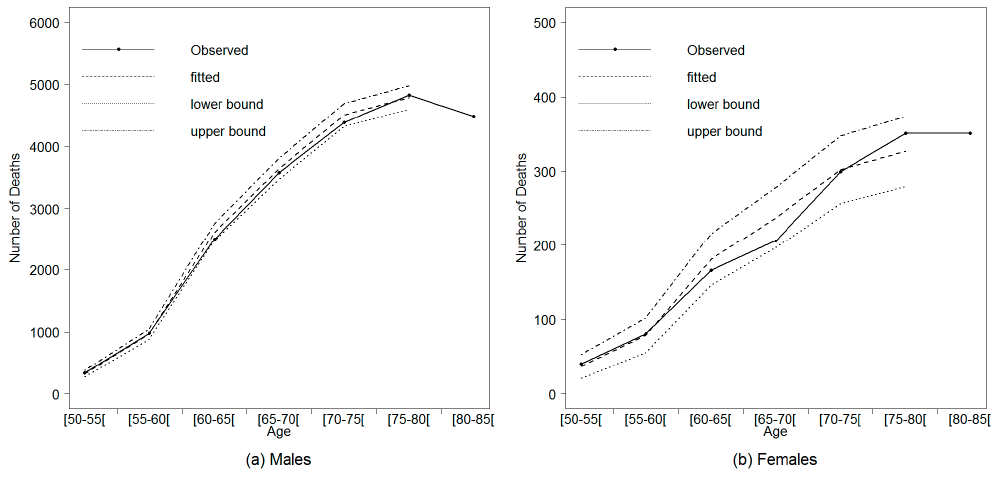
Figure 14. Confidence bounds of the number of deaths predicted by the quadratic regression for males and females.